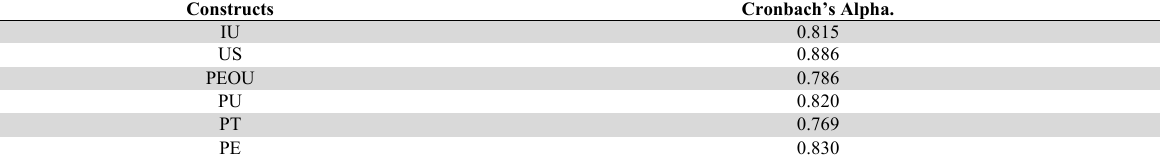
Cronbach’s Alpha values for the pilot study (Cronbach’s Alpha ≥ 0.70)